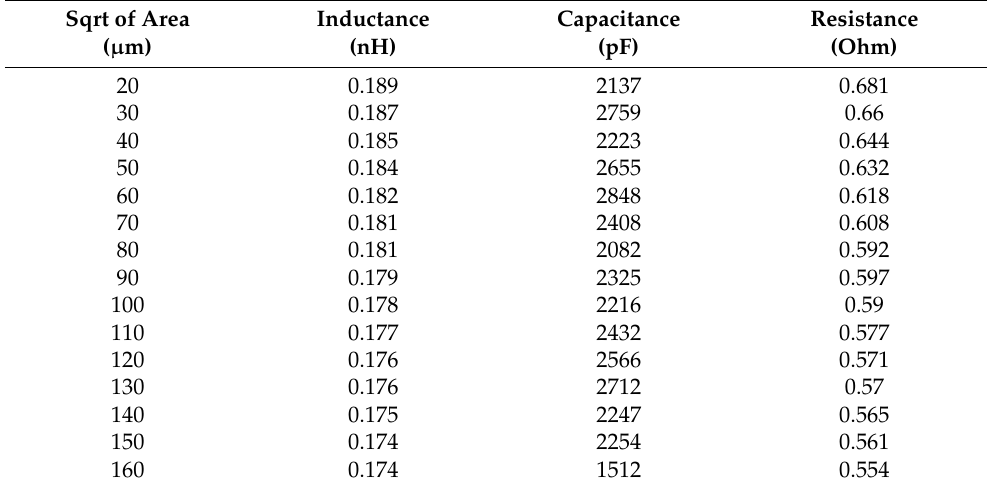
Table 1. Extracted circuit parameters of the pad and electrode layout from the EM